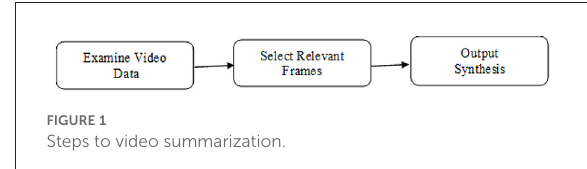
FIGURE1 Steps to video summarization.